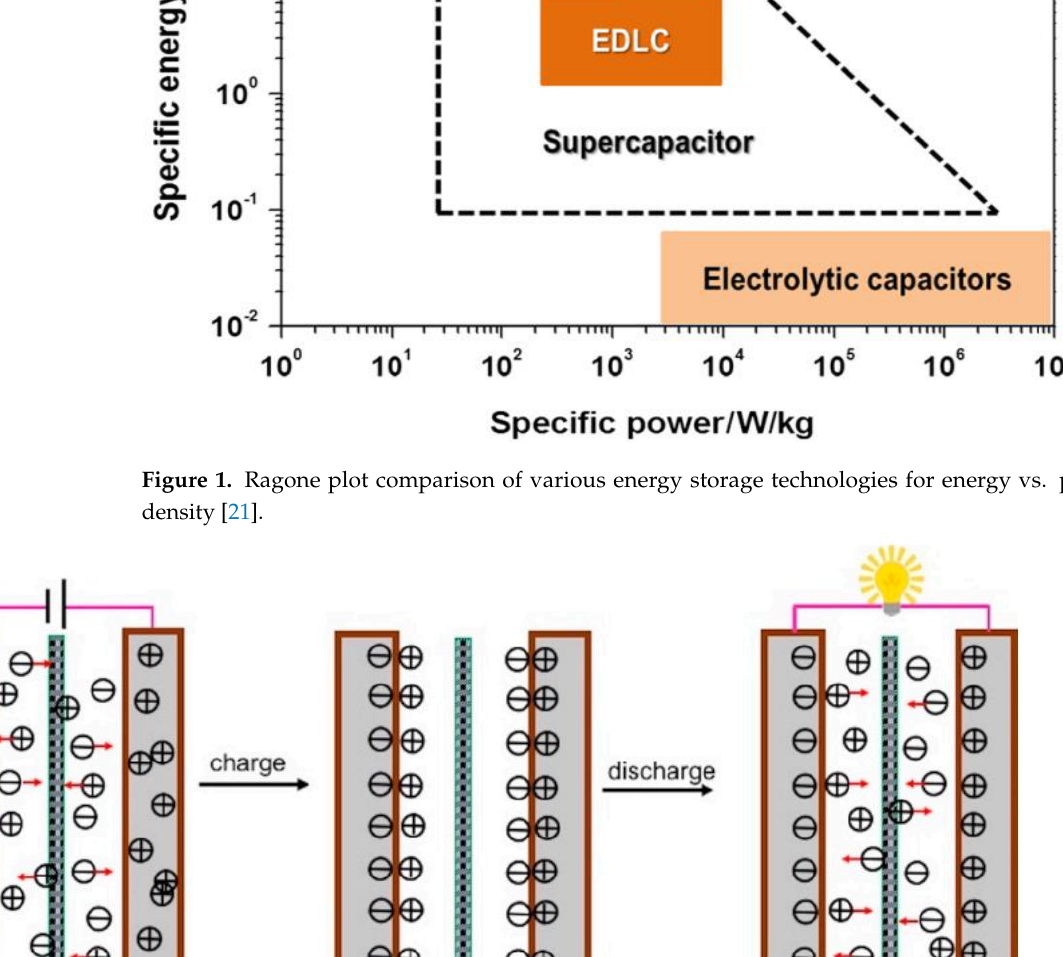
Figure 3. EDL model, ( a ) Helmholtz model, ( b ) Gouy – Chapman model, and ( c ) Stern model. Re- printed with permission from ref. [1]. 2016 Elsevier. In 1970s, Conway and Trasatti proposed another route for storing capacitive charge, known as pseudocapacitance. Faradic reactions are reversible and involve a change in the valence state of an electrode material as the result of a battery-like redox reaction (oxida- tion and reduction occurring simultaneously) [27,28]. In general, metals, metal oxides and conductive polymers are recognized as pseudocapacitive electrode materials. Pseu- docapacitive materials store charge by redox reactions. Basically, batteries and superca- pacitors also involve redox reactions, but the reaction kinetics are distinctly different. The charge storage mechanisms of supercapacitors fall into four groups: (1) redox pseu- do-capacitance, (2) intercalated pseudo-capacitance, (3) pseudo-capacitive doping, and (4) low-potential deposition-based pseudo-capacitance, as shown in Figure 4.